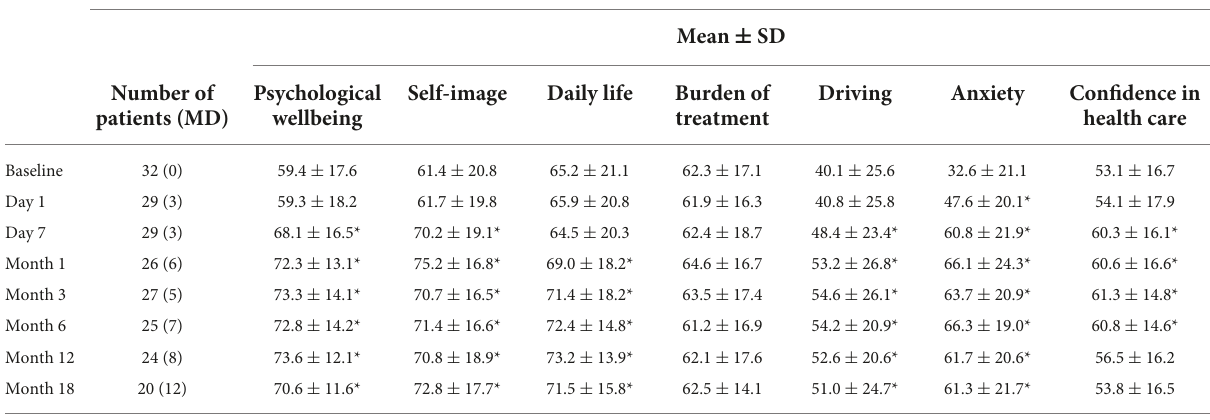
TABLE 4 Score distribution of the health-related quality of life domains for patients.